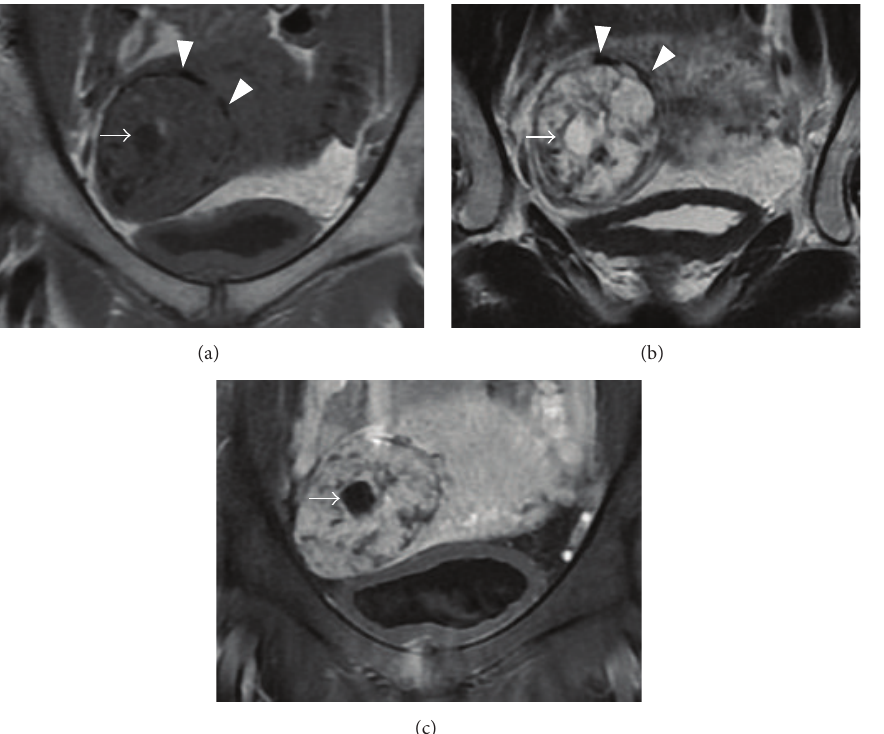
Figure 2: Coronal MRI images. (a) T1-WI shows an isosignal intensity mass in the right cornu. The mass includes a cyst (arrow) and shows low signal intensity. Several flow voids (arrow heads) are observed at the edge of the mass. (b) T2-WI. The mass and cyst (arrow) show high signal intensity. Several flow voids (arrow heads) are observed at the edge of the mass. (c) Gadolinium-enhanced and fat-suppressed T1-WI demonstrates a well-enhanced mass and clear margins. Arrow indicates the